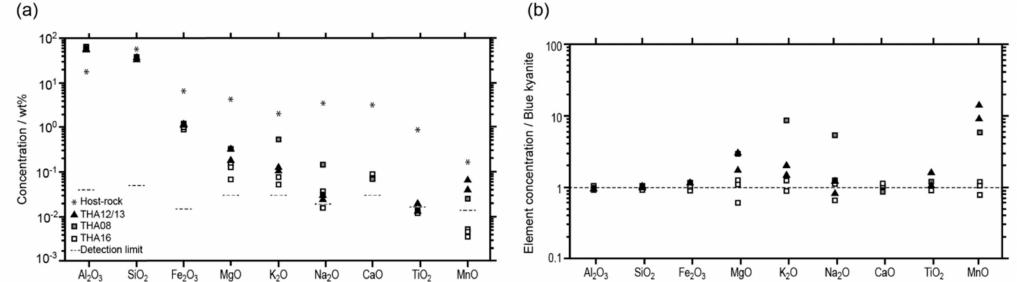
Figure 9. Distribution of measured oxides in CS16_292b host-rock and in blue-green (THA16), yellow (THA08) and orange (THA12 and THA13) kyanite samples. ( a ) Raw concentration. ( b ) Concentration normalized to the average value of the three blue-green THA16 samples.